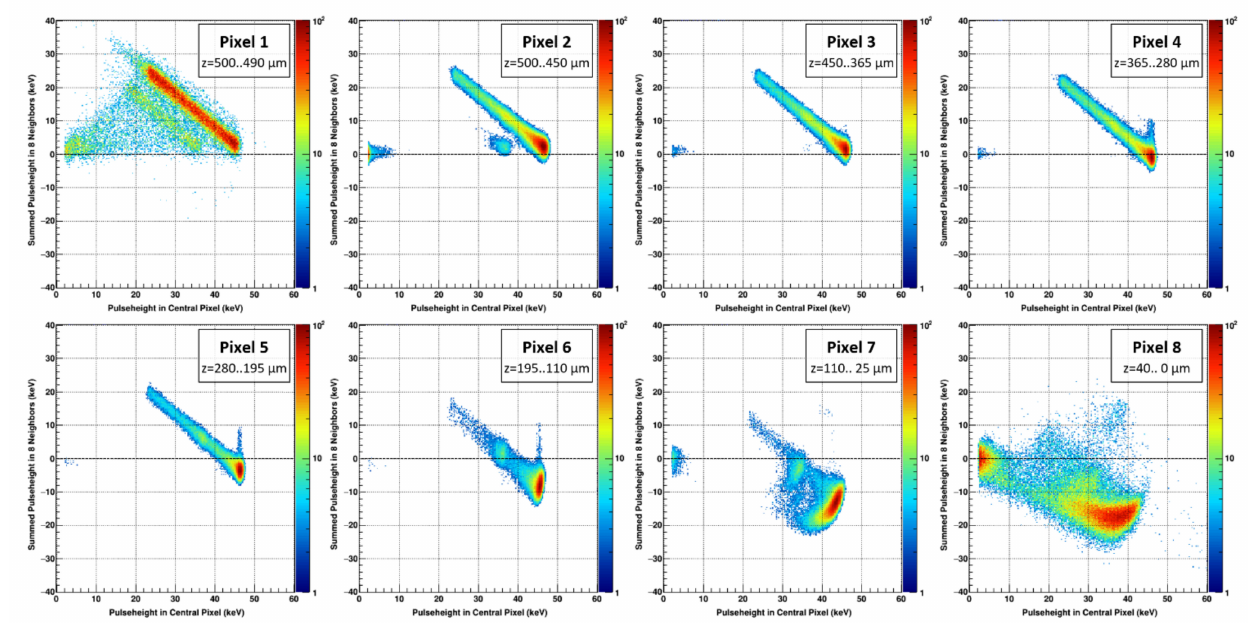
Figure 10. Experimental data of the 45 keV focused beam impinging on the sensor at a 48.6 degree angle. The plots show the correlation between the sum of the signals in the eight neighbors (y-axis) as function of the signal in the central pixel (x-axis) of a 3 × 3 cluster for different absorption depths in the sensor. The z-axis of each plot is normalized to its highest signal.